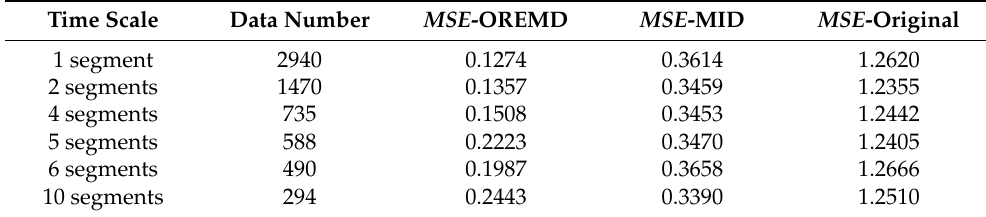
Figure 10. ( a ) M = 6. The trend of MSE with r. ( b ) r = 0.9, n = 90. The trend of MSE with M. ( c ) Sensitivity chart of OREMD. Table 6. MSE statistics on different time